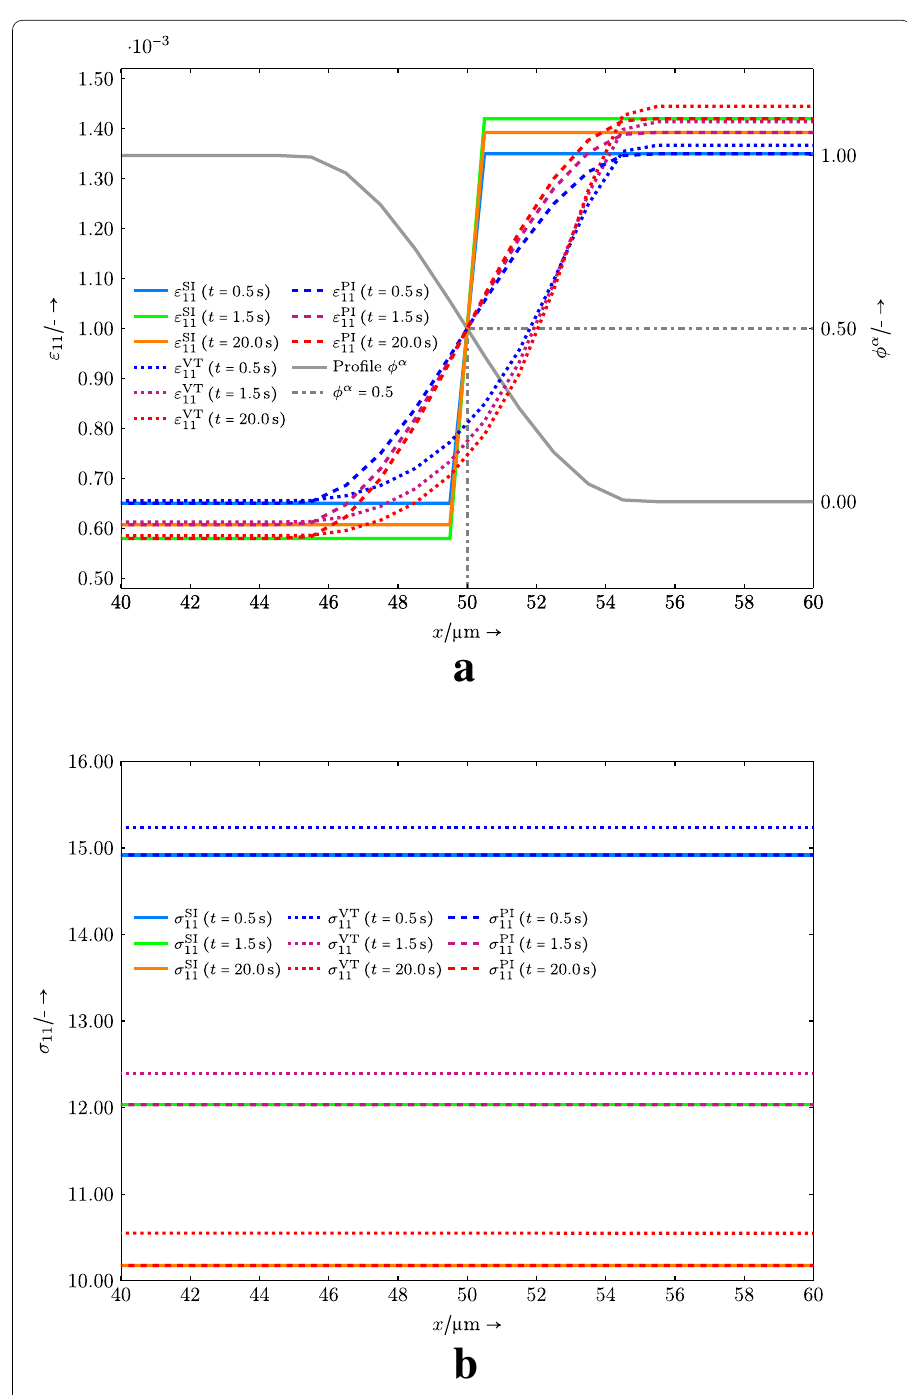
Fig. 6 Results for a ε 11 and b σ 11 : Comparison of the VT and the PI approach in mechanics to the sharp-interface solution. Three different times ( t = { 0 . 5 , 1 . 5 , 20 . 0 } s) are plotted along x with y = 49 . 5 µ